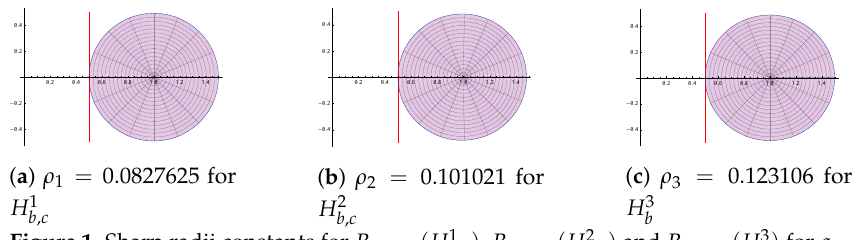
Figure 1. Sharp radii constants for R S ∗ ( 1